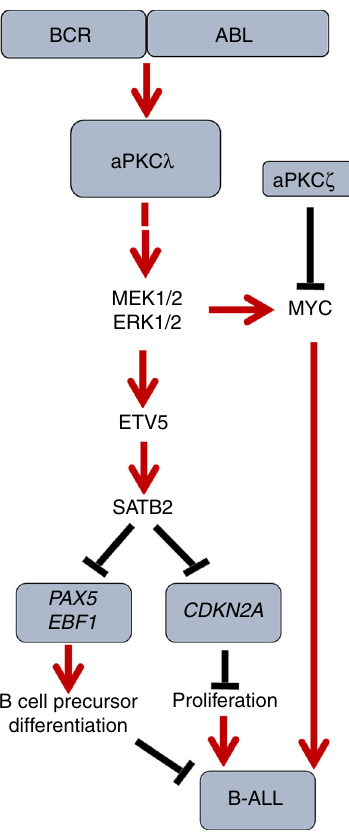
Fig. 7 Schematic diagram of the roles of aPKC λ and – ζ in regulating B-ALL. The aPKC λ dependent Mek/Erk-Etv5-Satb2 axis plays a crucial role in the proliferation and differentiation of leukemic B-cell progenitors through Satb2 mediated epigenetic